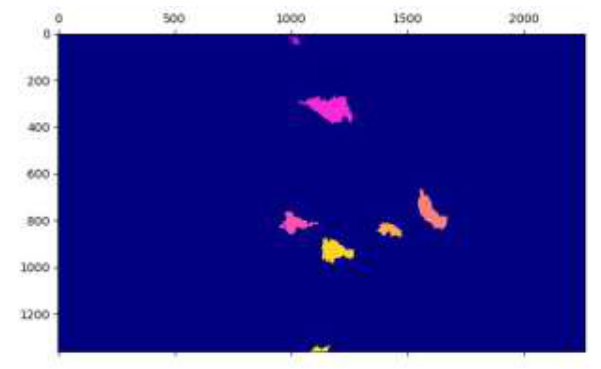
Figure 9. June 2, 2016 actual HRRR data